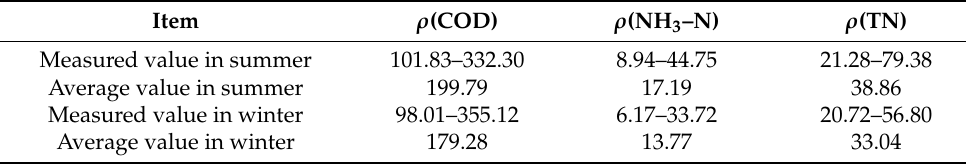
Table 1. The quality of the inlet water mg/L.